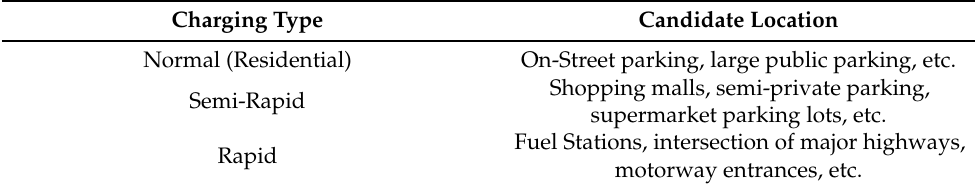
Table 7. Example of candidate locations for optimization